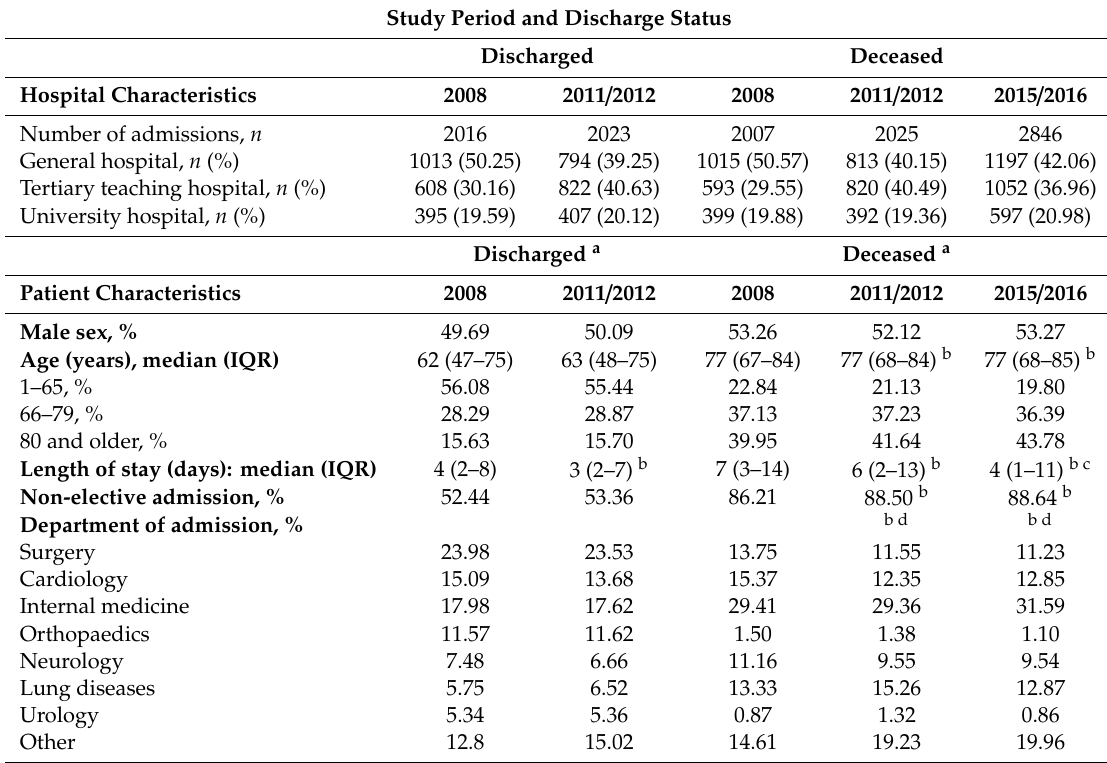
Figure 1. Overview of the total screened population and adverse events identified. MRAE: Medication related adverse event; AE: Adverse event; ARAE: Antithrombotic-related adverse event. Table 1. Patient characteristics and adverse events per study period and discharge status.